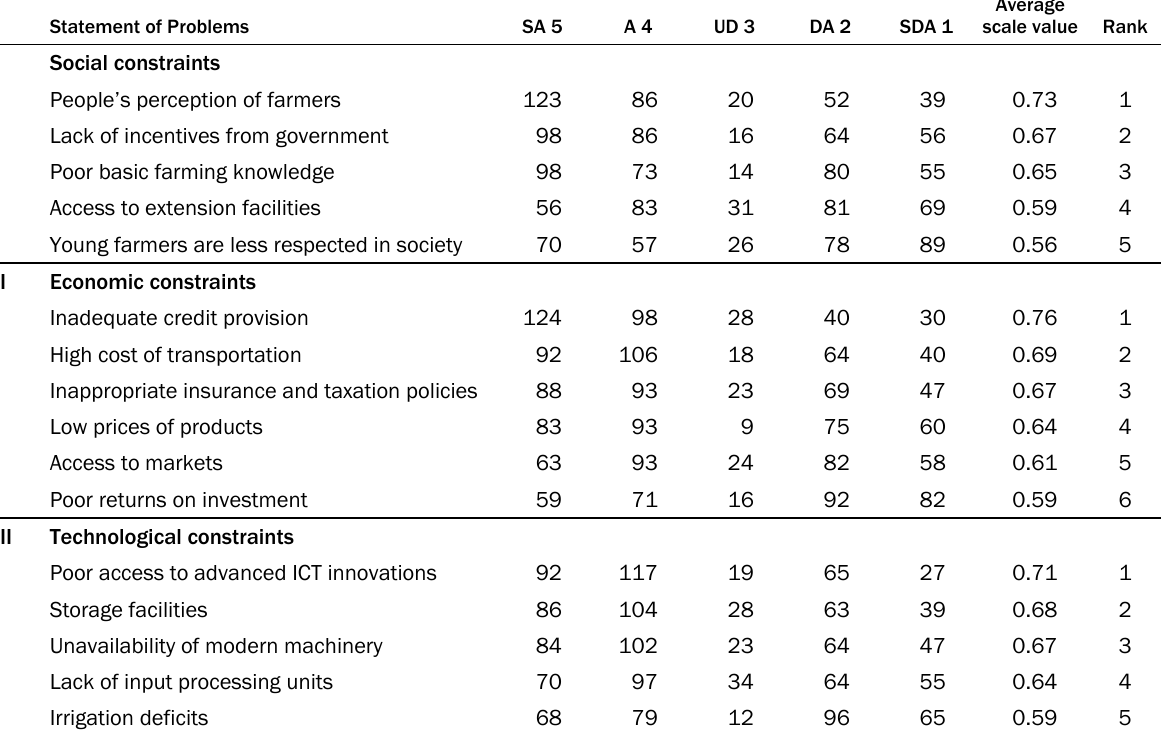
Table 7. Constraints Faced by Youth in Transforming the Economy Through Agriculture